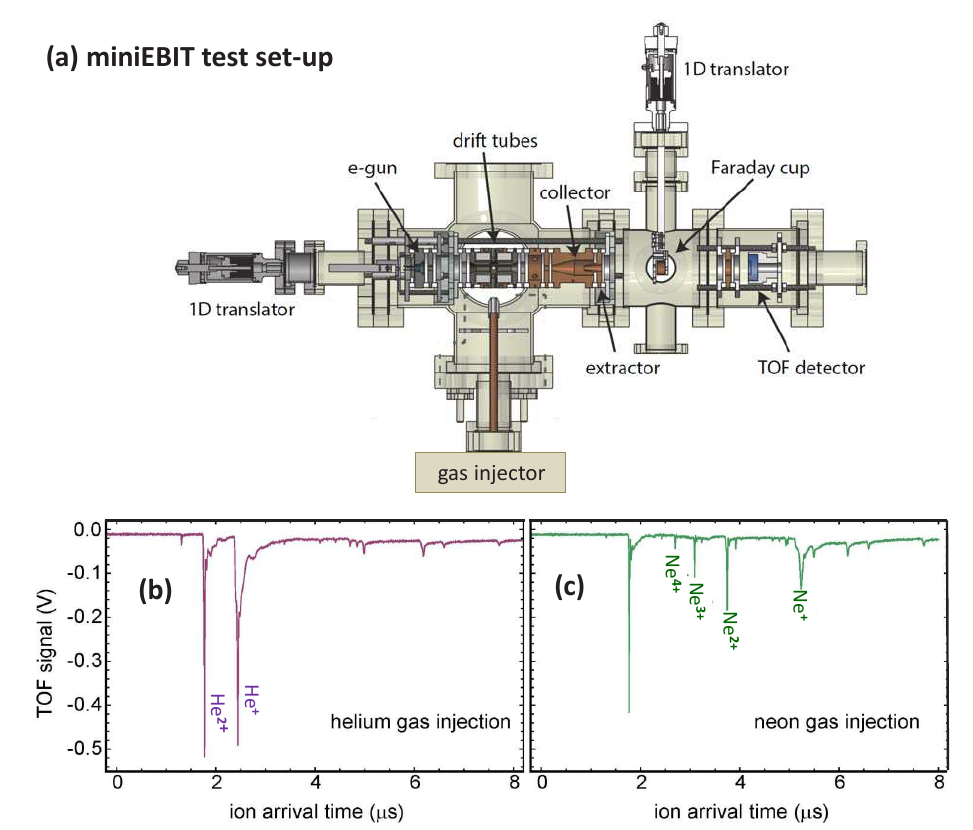
Figure 10. ( a ) Schematic diagram of the apparatus for testing a miniature EBIT